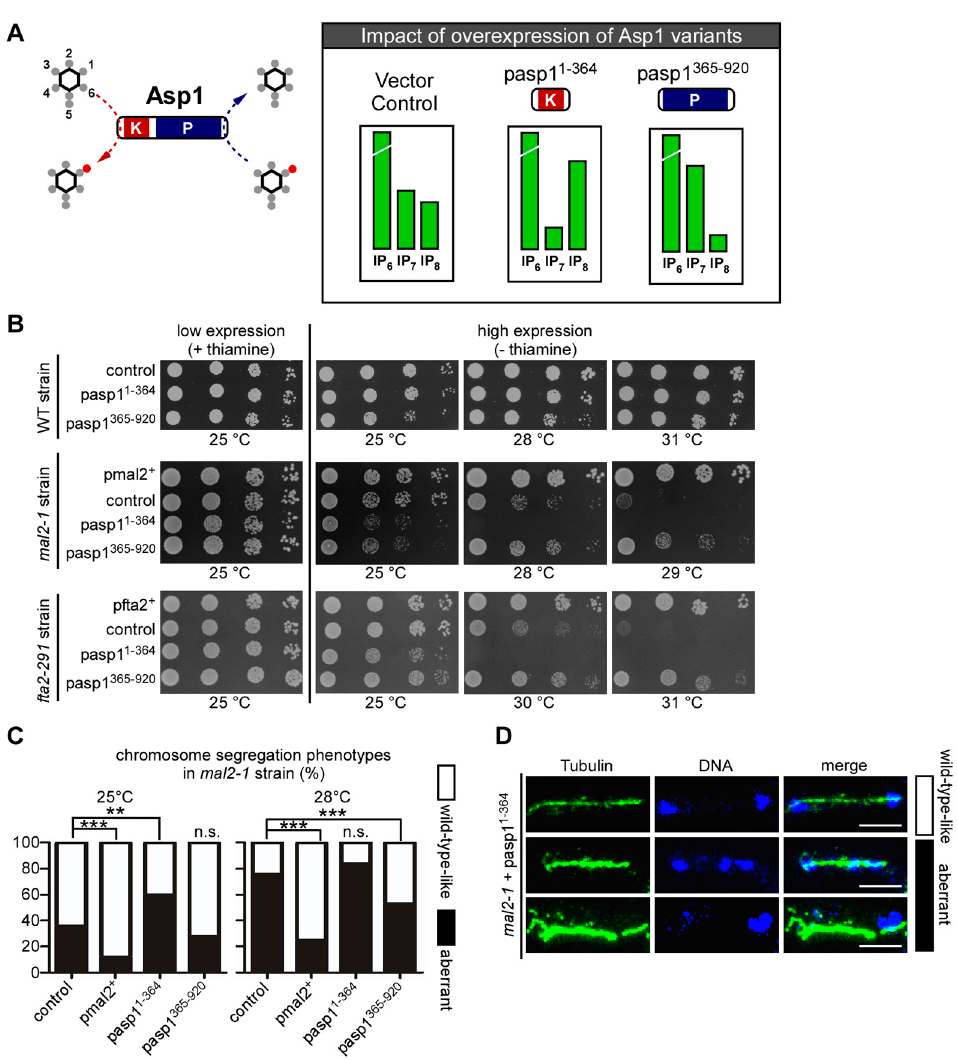
Figure 3. Alteration of IP 8 levels affect the temperature-sensitive growth phenotype of CCAN kinetochore mutant strains . ( A ) Schematic representation of the impact in IP 7 and IP 8 levels upon the expression of the Asp1 kinase (Asp1 1 − 364 ) and pyrophosphatase (Asp1 365 − 920 ) variants [36,37]. ( B ) Serial dilution patch test (10 4 –10 1 cells) of wild-type (WT), mal2-1 and fta2-291 strains that were transformed with the indicated plasmids and grown at the indicated temperature for 4–8 days depending on the incubation temperature. pmal2 + ; plasmid with wild-type mal2 + ORF expressed via the nmt1 promoter. nmt1 transcribed genes show low expression in the presence of thiamine and high expression when no thiamine is present. pasp1 1 − 364 and pasp1 365 − 920 , plasmids with nmt1 driven expression of the Asp1 kinase or pyrophosphatase domains, respectively. One of n = 3 shown. ( C ) Quantification of chromosome segregation phenotypes that were observed in a mal2-1 strain transformed with the indicated plasmids. 25 °C: **, p = 0.0011 ***; p < 0.0001. 28 °C: ***, p < 0.0001 ( mal2 + ); ***, p = 0.0007 (asp1 365 − 920 ), n.s., not significant. Fisher’s exact test. n = 100 cells per plasmid. One of n = 2 shown. ( D ) Immunofluorescence of fixed mal2-1 cells that were transformed with pasp1 1 − 364 and grown at 25 °C. Green, α -TAT1 (tubulin); blue, DAPI staining. Scale bars, 5 µm.